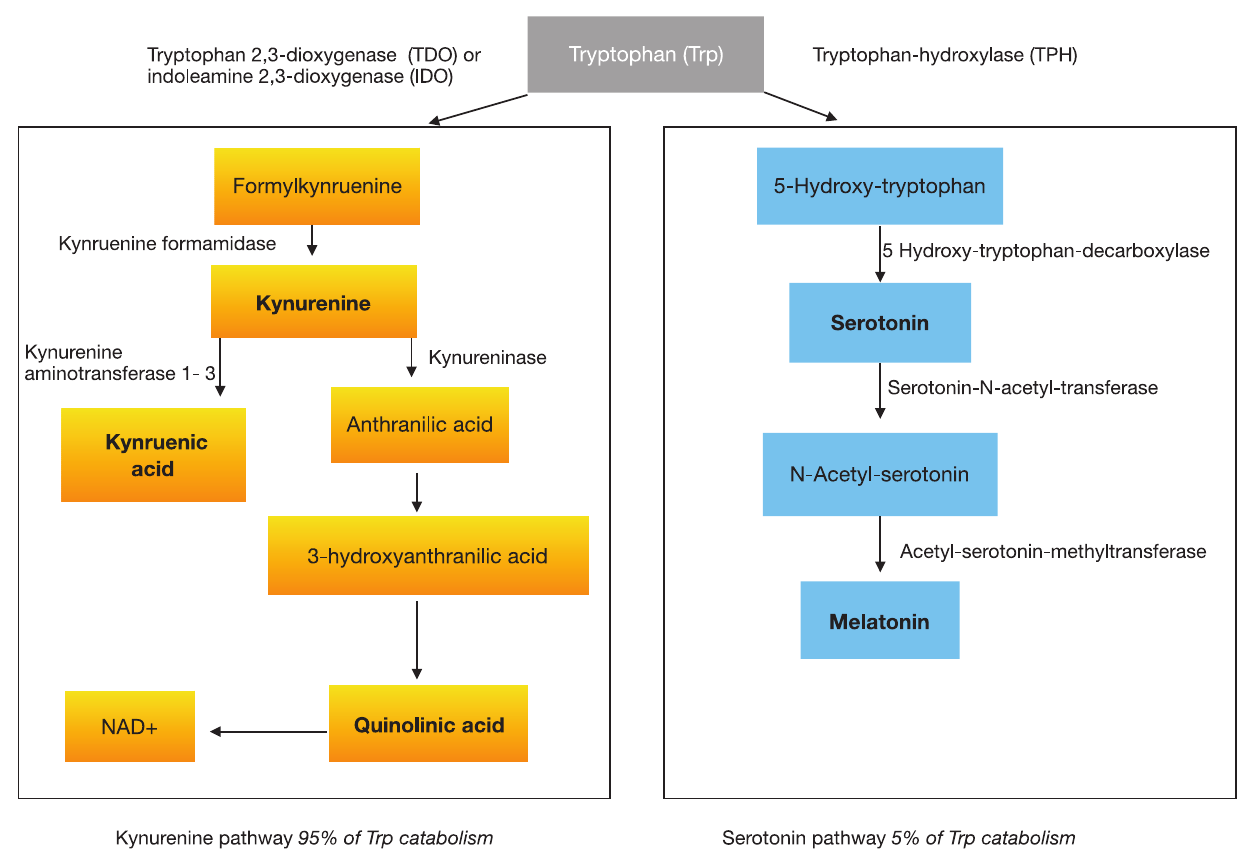
FIGURE 1 | Tryptophan